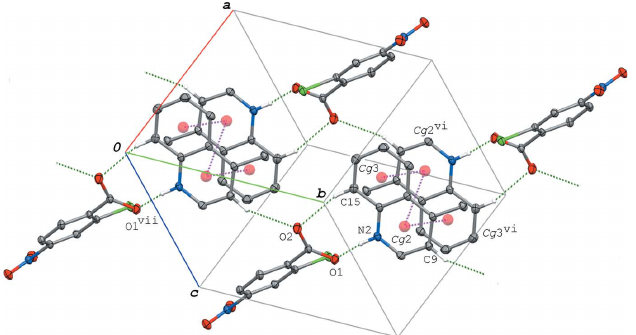
Figure 2 A packing diagram of (I), showing the ribbon structure running along the b- axis direction formed via the N—H (cid:2)(cid:2)(cid:2) O and C—H (cid:2)(cid:2)(cid:2) O hydrogen bonds (green dashed lines) and (cid:2) – (cid:2) interactions (magenta dashed lines). H atoms not involved in the hydrogen bonds are omitted for clarity. Cg 2 and Cg 3 are the centroids of the N2/C8–C11/C16 and C11–C16 rings, respectively. [Symmetry codes: (vi) (cid:3) x + 1, (cid:3) y + 2, (cid:3) z + 1; (vii) x , y (cid:3) 1, z